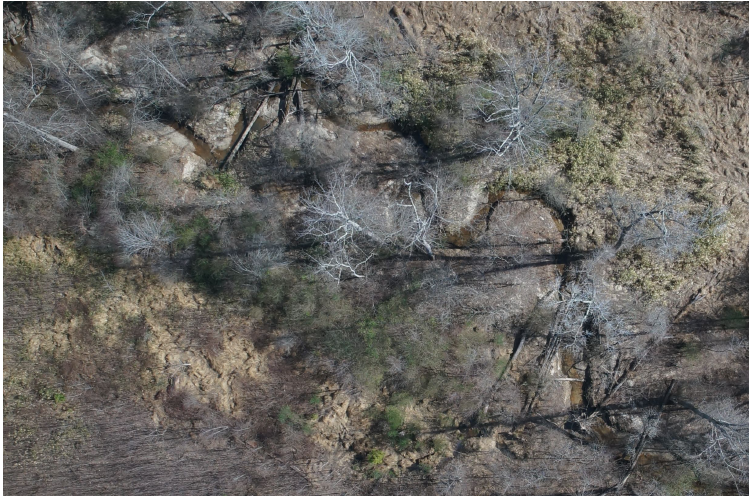
Figure 6. An RGB imagery of wetland area captured by Sony NEX-5T camera mounted on Trimble UX5 (see Figure 4). Flight altitude—135 m, data captured 17 February